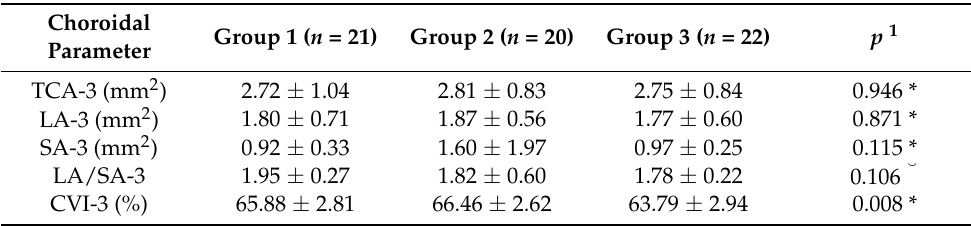
Table 5. Choroidal parameters in the studied groups for the choroidal area under the 3 mm horizontal line centered on the fovea.